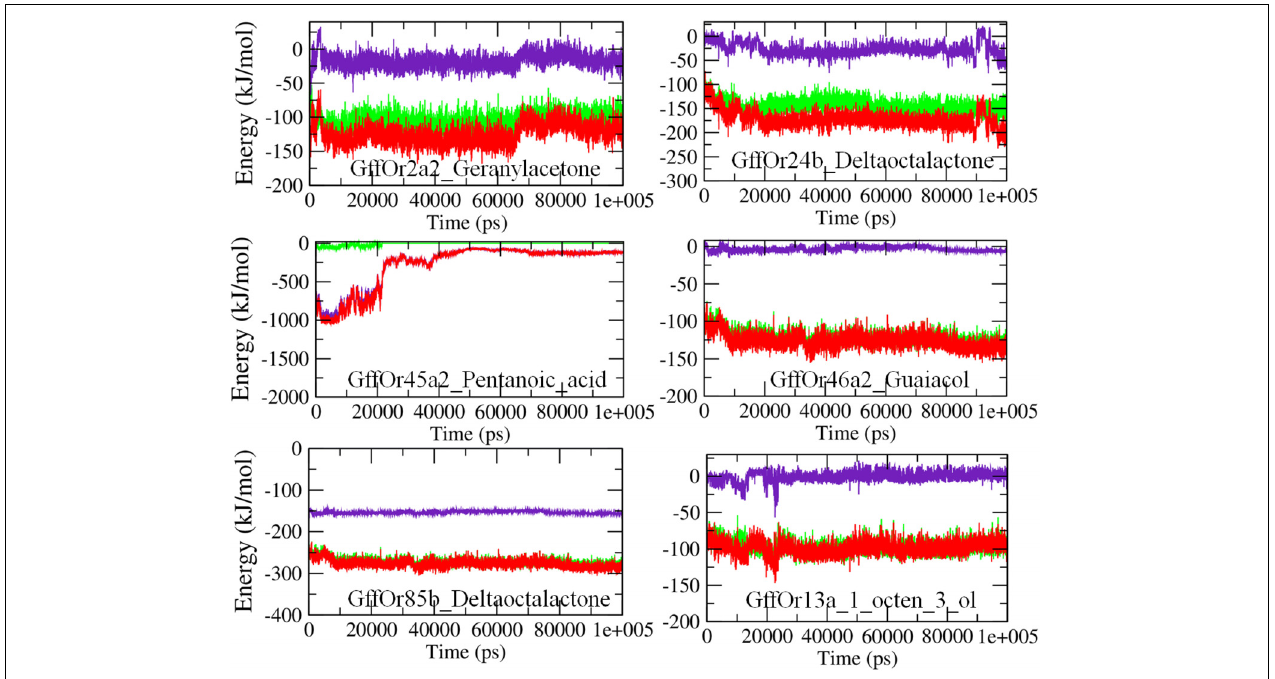
FIGURE 6 | The MM/PBSA based energy curves highlighting the changes observed in the pattern of the interaction energies observed between the studied receptors and ligands during the course of 100-ns MD simulations. Green, van der Waals energy; indigo, electrostatic energy; red, total energy.